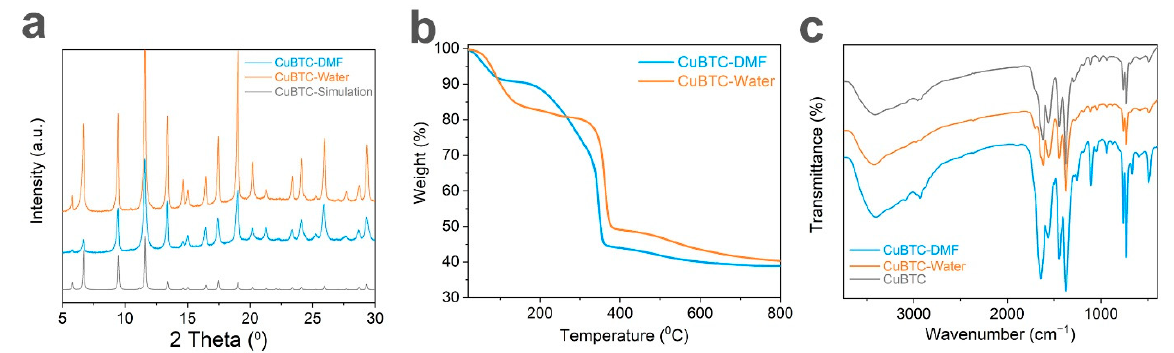
Figure 1. ( a ) PXRD patterns, ( b ) TGA and ( c ) FTIR spectrum of CuBTC-DMF and